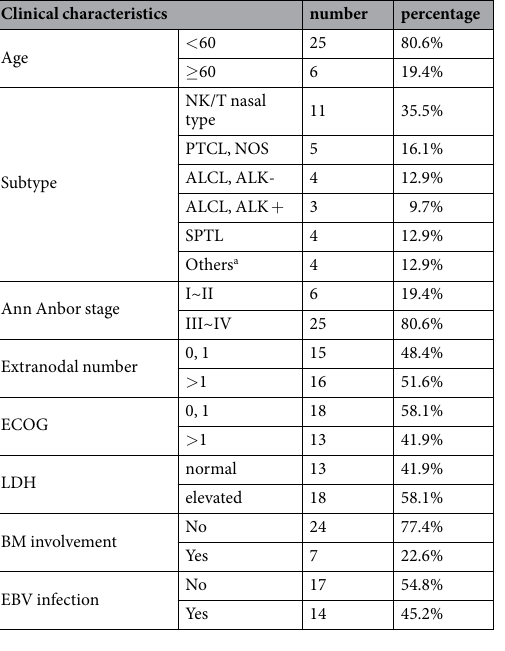
Table 1. The clinical characteristics of 31 T-NHL patients enrolled in the prospective study. a Others: 1 AITL, 1 EATL, 1 ANKL and 1 Sezary. b Abbreviations: PTCL, NOS: peripheral T-cell lymphoma, not otherwise specified; ALCL: anaplastic large cell lymphoma; ALK: anaplastic lymphoma kinase; SPTL: subcutaneous panniculitis- like T-cell lymphoma; AITL: angioimmunoblastic T-cell lymphoma; EATL: epitheliotropic intestinal T-cell lymphoma; ANKL: aggressive natural killer-cell leukemia; BM: bone marrow;